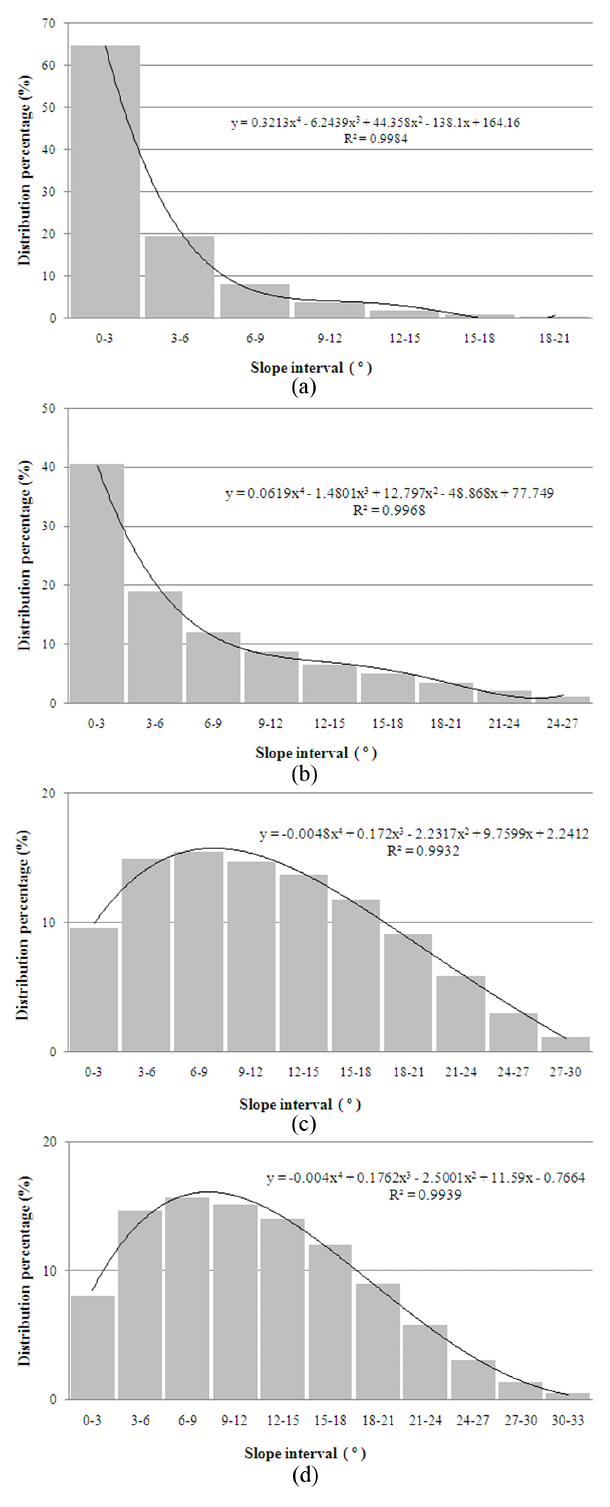
Figure 7. Slope spectrum and its quantitative analysis for the sub- types of the loess tableland. (a) Loess terrace, (b) complete table- land, (c) residual tableland and (d) beam